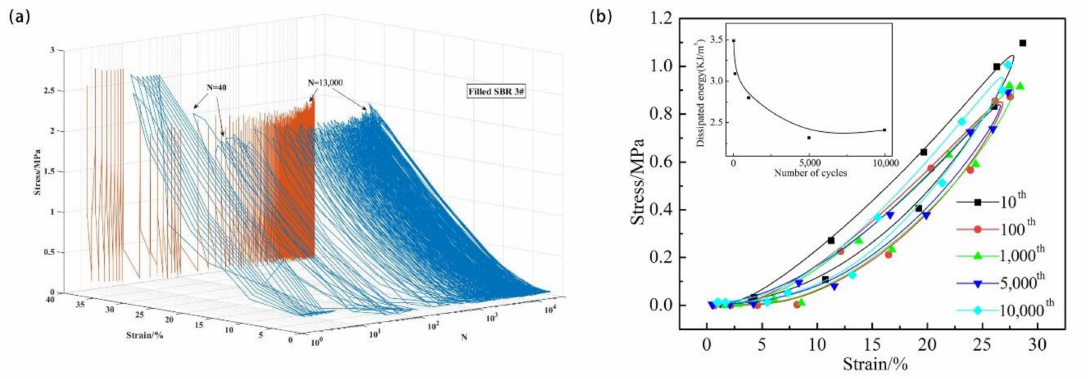
Figure 1. ( a ) Three-dimensional hysteresis loops of filled SBR 3, ( b ) stress–strain curves (2D hysteresis loops for several certain loading cycles), and corresponding dissipated energy of two samples during 10,000 fatigue